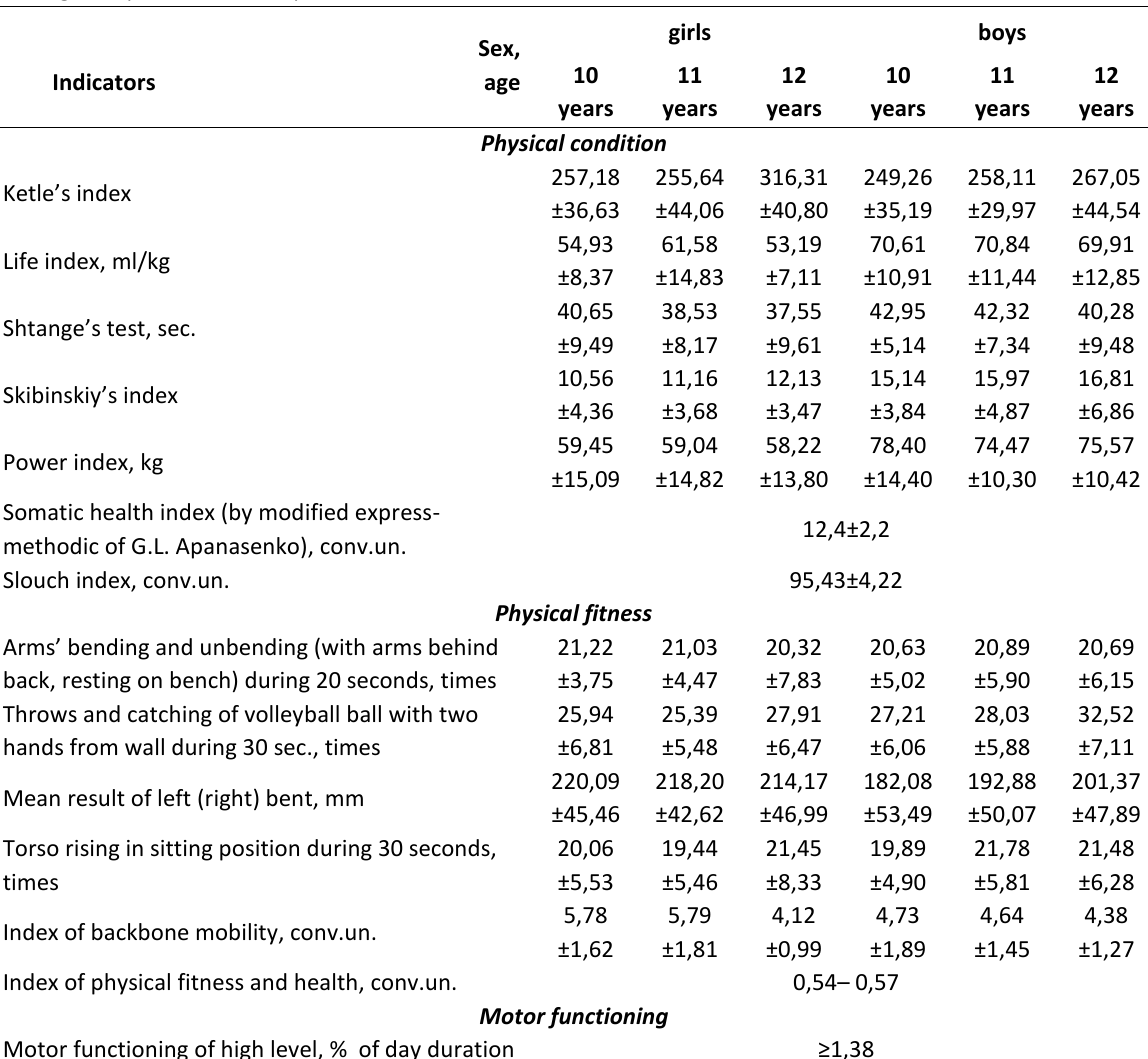
Table 4. Optimal values of physical condition, physical fitness and motor functioning (Х±σ) of 10-12 years old pupils with high adaptive-functional potentials